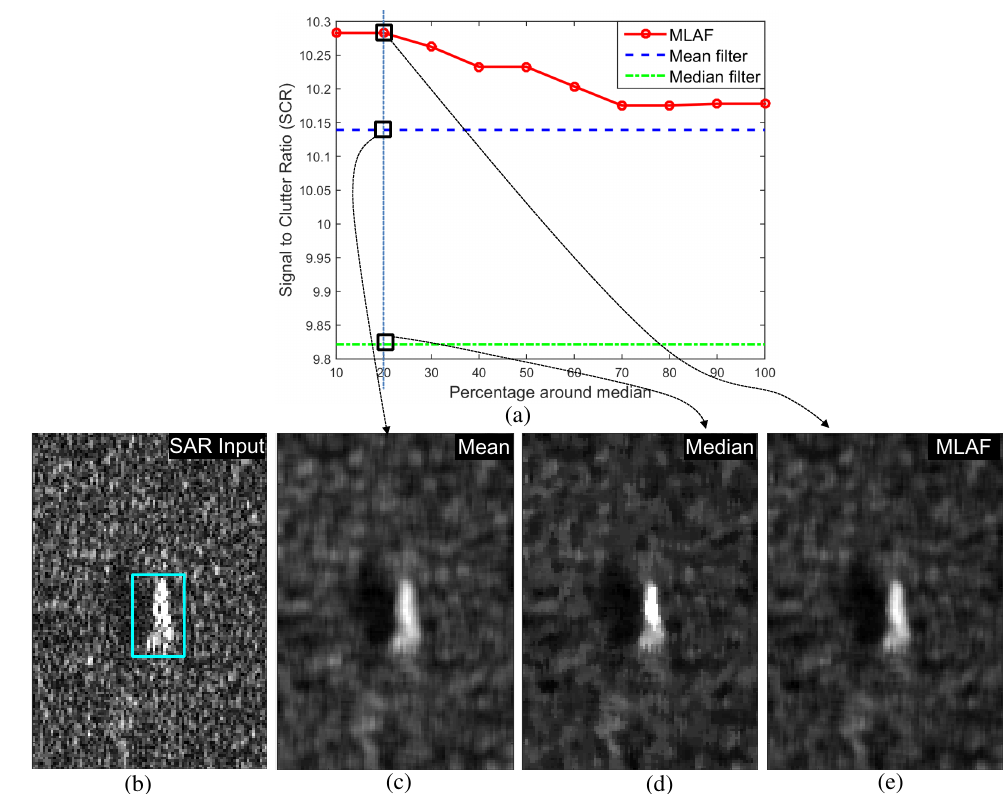
Figure 22. SAR noise removal comparison: ( a ) signal-to-clutter ratio by varying the percentage around the median value in MLAF; ( b ) IR test image; ( c ) mean filter result (5 × 5); ( d ) median filter result; ( e ) proposed MLAF result at 20% around the median.